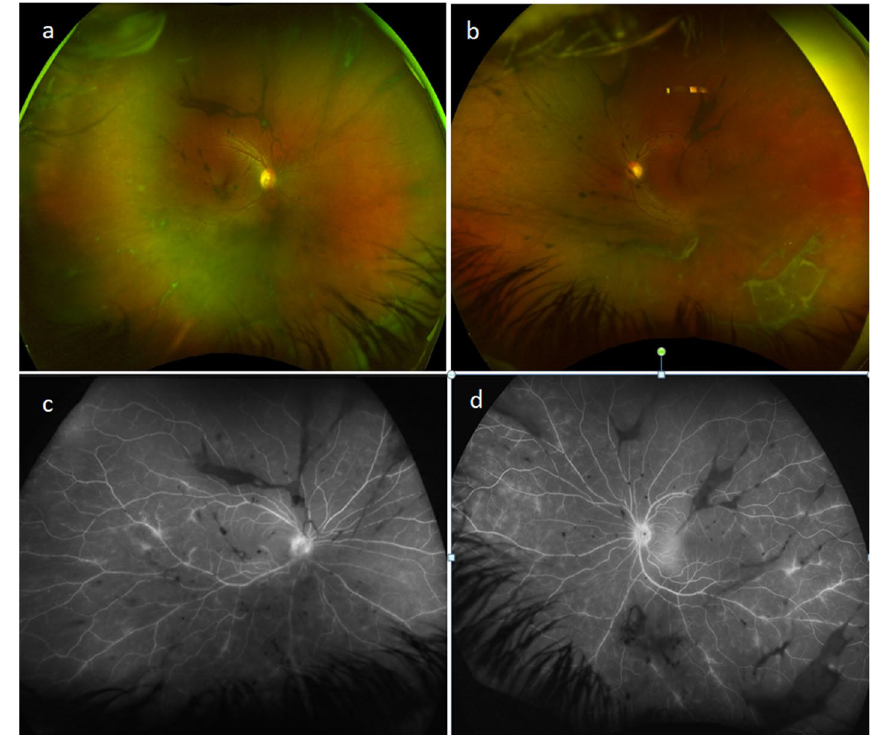
Fig. 1 a , b : right and left eye wide field fundus photos showing coarse vitreous condensations and subtle peripheral vasculitis c , d : late venous phase wide field fundus fluorescein angiography showing bilateral diffuse peripheral capillaritis and non occlusive vasculitis involving secondary and tertiary veins with no retinal ischemia and no macular capillary leakage. Hyper fluorescence of the disc was noted in both